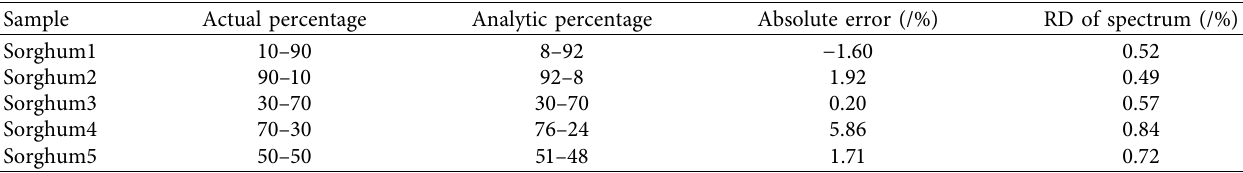
Table 10: The analytic percentage, the actual percentage, the absolute error of both, the relative deviation between the actual mixed homogeneous spectrum, and the simulated mixed spectrum for sorghum